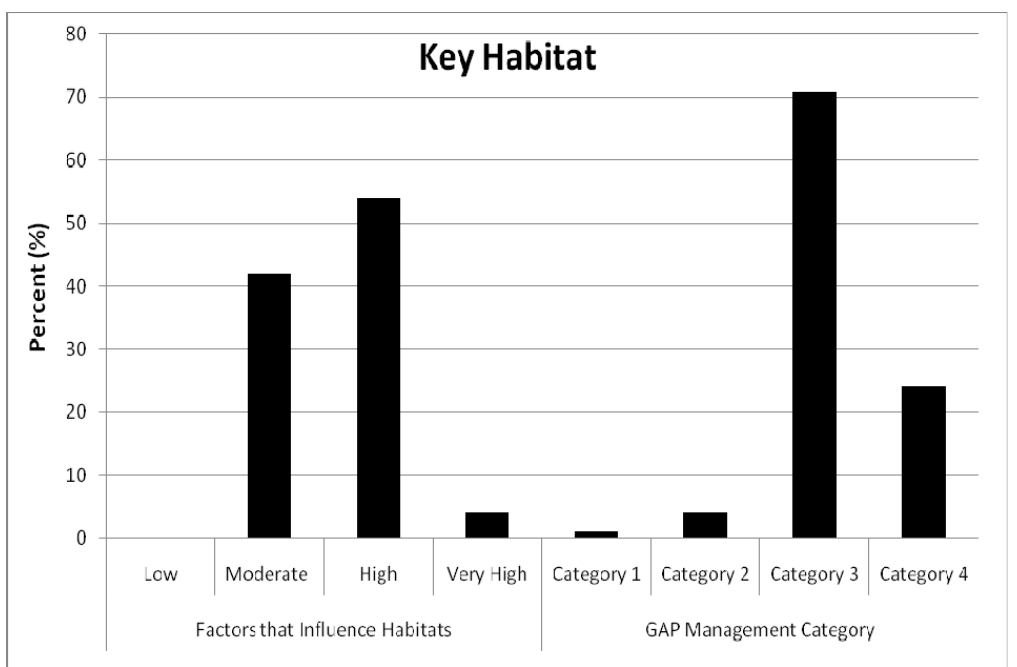
Figure 6. Comparison of area percent for factors that influence habitats and reclassed management category by key habitats in New Mexico.